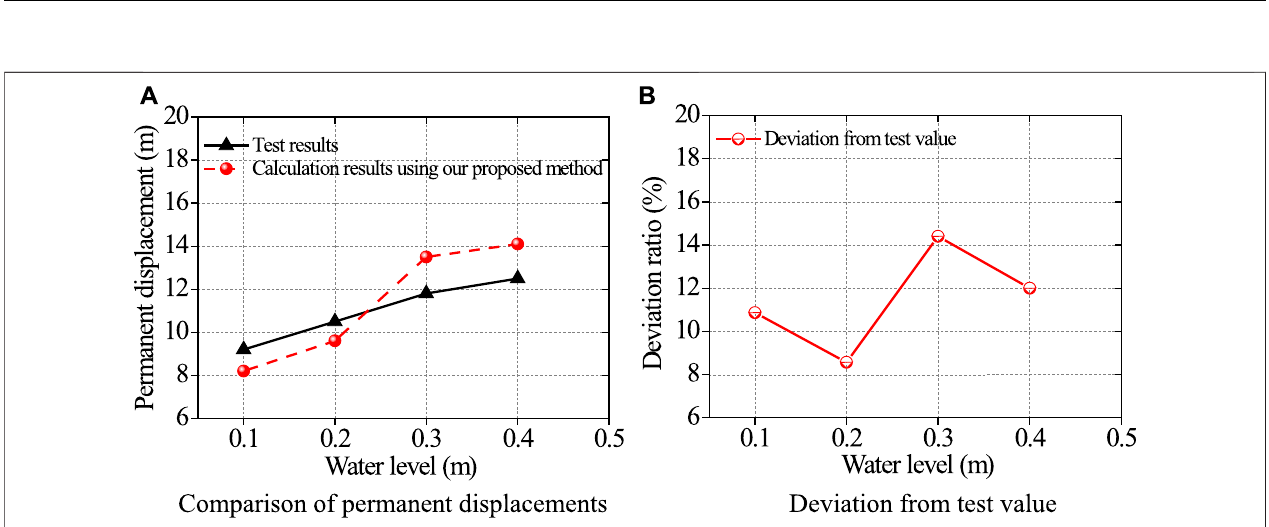
FIGURE18| Comparisonofthetestvaluewiththecalculationresultsusingtheproposedmethod. (A) Comparisonofpermanentdisplacements. (B) Deviationfrom the test value.